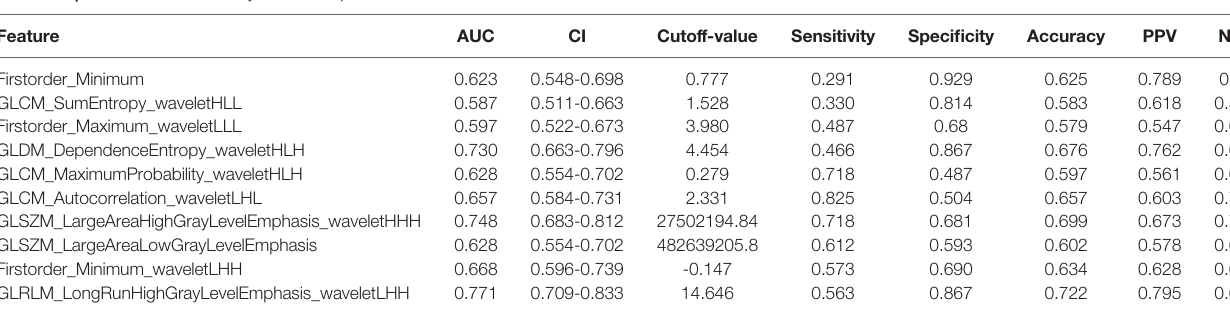
TABLE 4 | Confusion matrix analyses of 10 optimal radiomics features. Feature